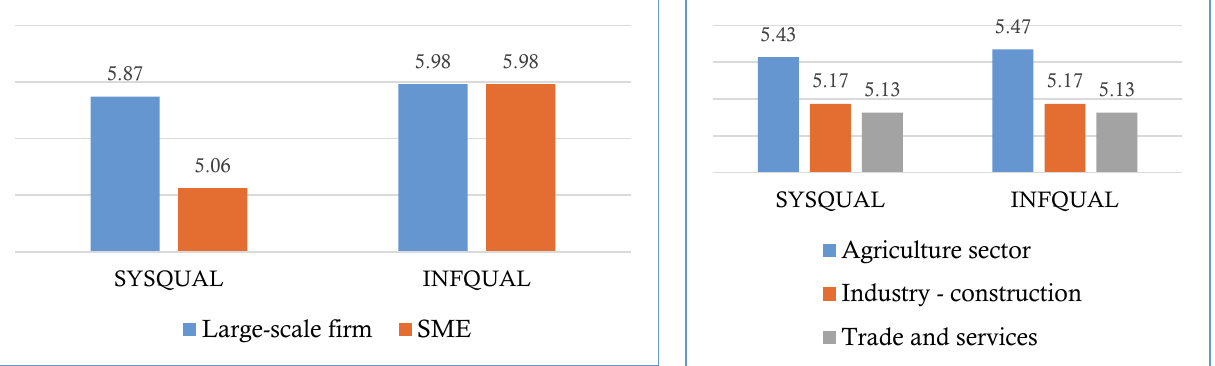
Fig. 3. The quality of accounting information systems by the firm size and business